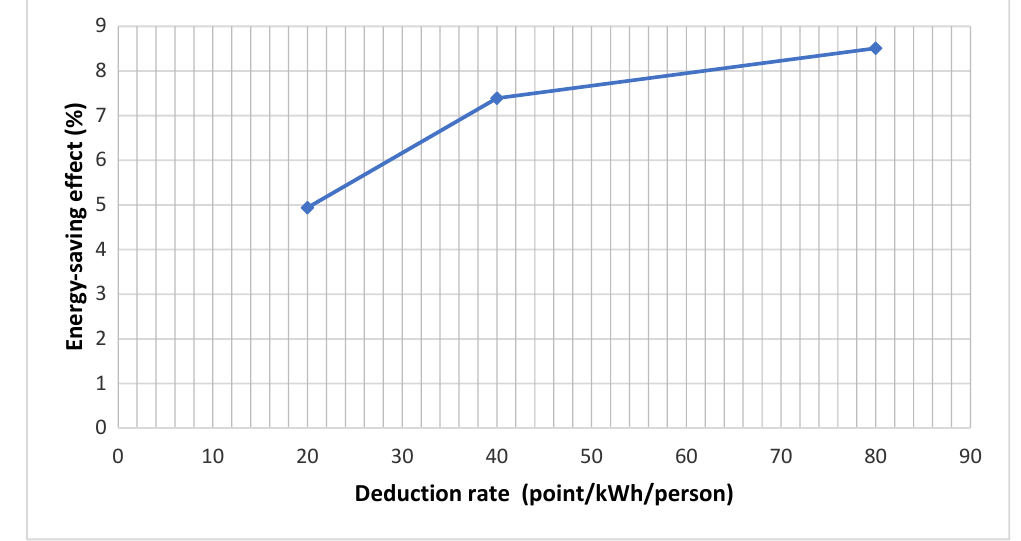
Figure 7. Energy ‐ saving effect change according to deduction rate.